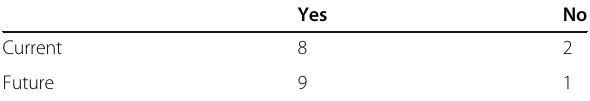
Table 5 Response to the question: “ Is it intended that a patient withdraw and at the same time already existing data continue to be available for research? ”